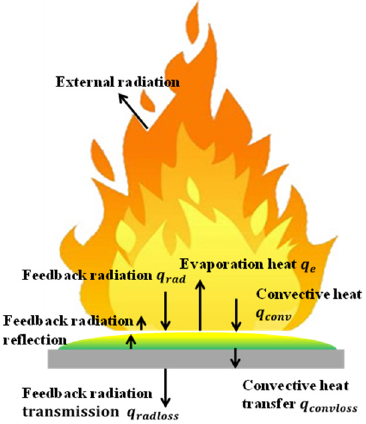
Figure 11. Heat transfer process of spill fire.